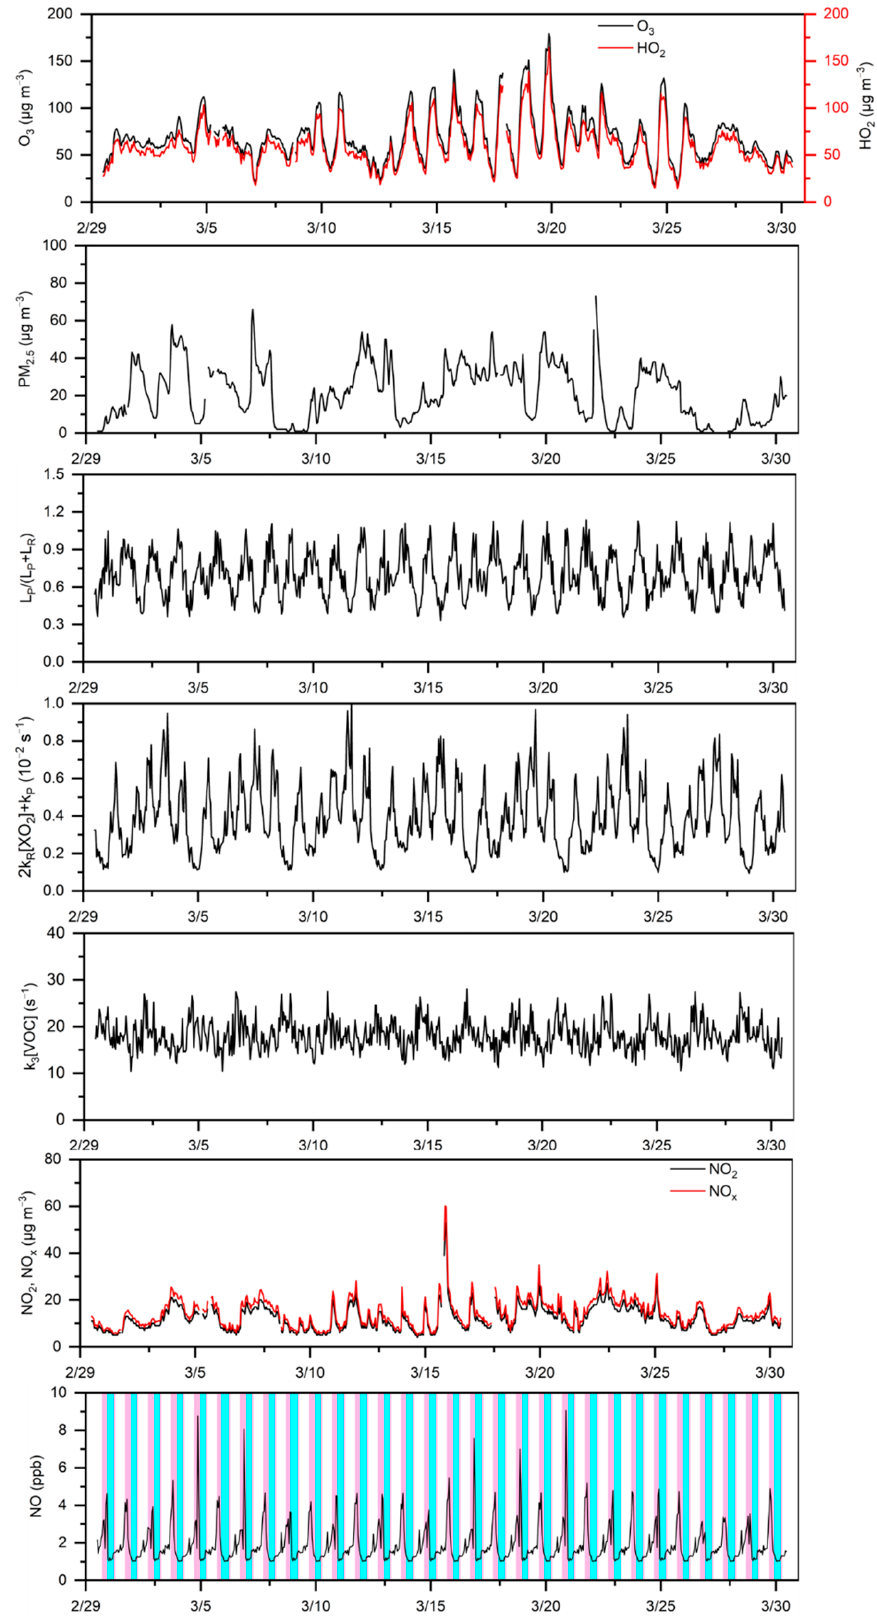
Figure 3. Temporal variations in key drivers from 1 March to 30 March, 2020 (UTC). These drivers include O 3 , HO 2 , k 3 [VOC], PM 2.5 , NO 2 , NO x , L P /(L P +L R ), NO, and 2k R [ XO 2 ] + k P